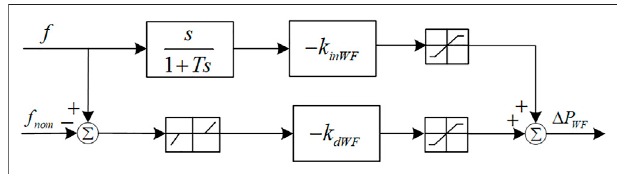
FIGURE 2 | Control block diagram of wind turbines participating in frequency